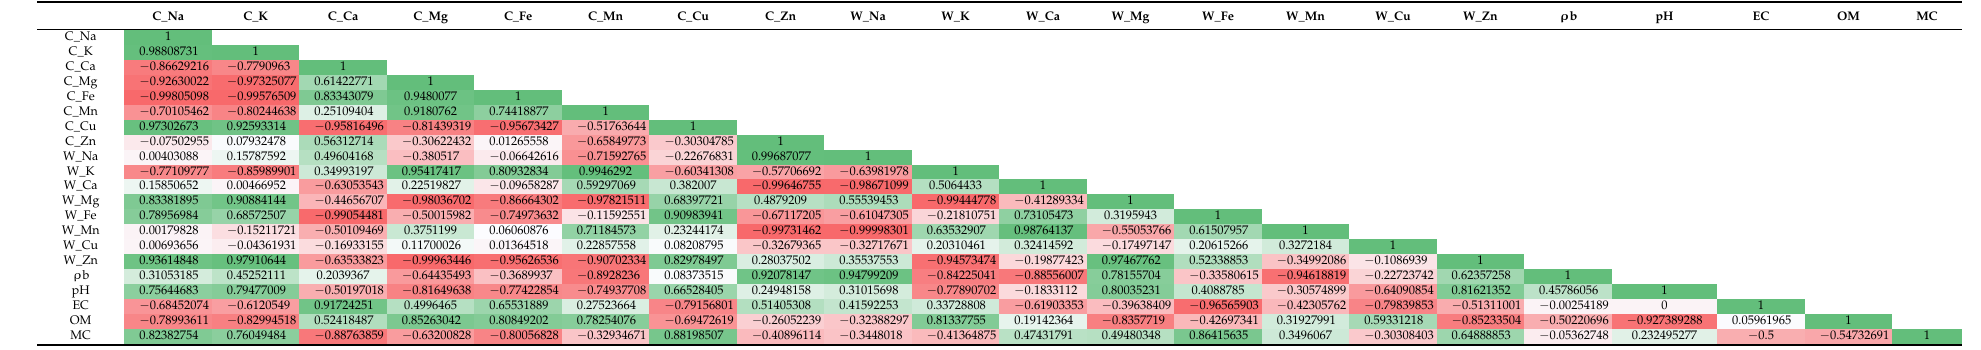
Table A3. Correlation coefficients between elemental composition nutrient content, water extractable nutrient content and physical and chemical properties of OP.